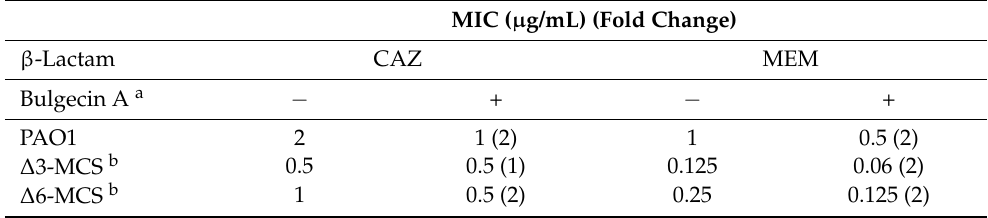
Table 2. Effect of bulgecin A on the MIC of CAZ and MEM against efflux pump- or porin-knockout mutants. MIC ( µ g/mL) (Fold Change) β -Lactam CAZ MEM Bulgecin A